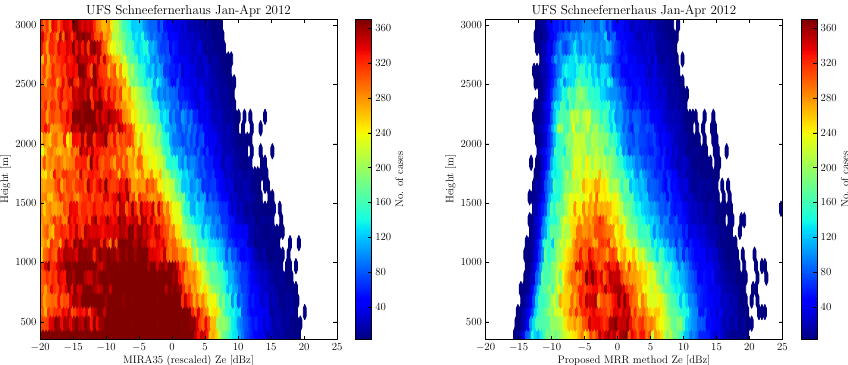
Fig. 8. Frequency by altitude diagram (CFAD) for Z e of MIRA35 (left) and for Z e of MRR using the new proposed method (right).